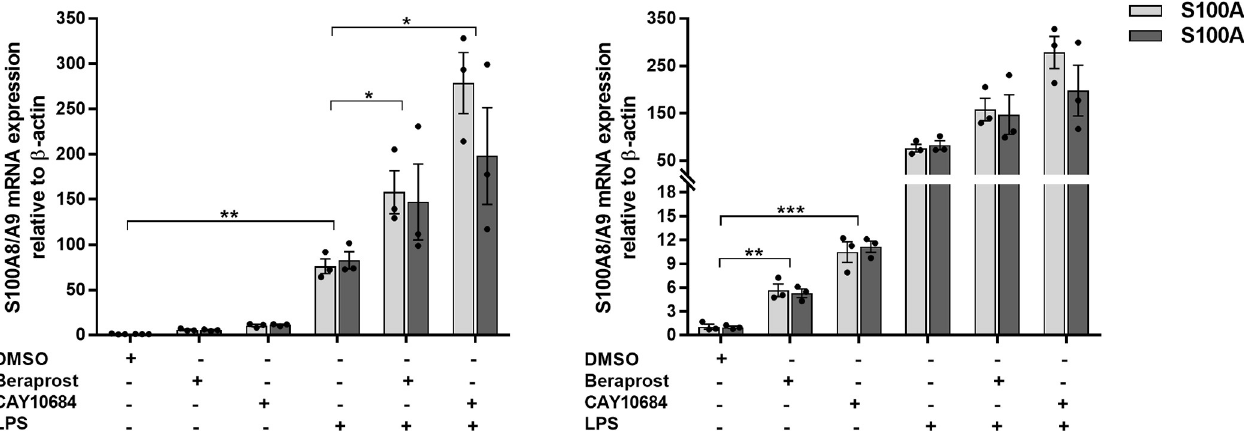
Fig 5. Impact of PG receptor agonists on the expression of S100A8/A9 in response to LPS. Relative in mRNA expression levels of S100A8/A9 genes were evaluated after incubating THP-1 for 24 hours with or without 0.2 ug/ml of LPS in the presence or absence of 1x10 -5 M of Beraprost or CAY10684, the agonists of PTGIR and PTGER4 respectively. Graph on the right represents the same data with different y-axis scale. Each bar is the mean of 3 samples from 3 different experiments ± SEM. � P < .05, �� P < .01, ��� P < .001 (Student’s t -test unpaired).